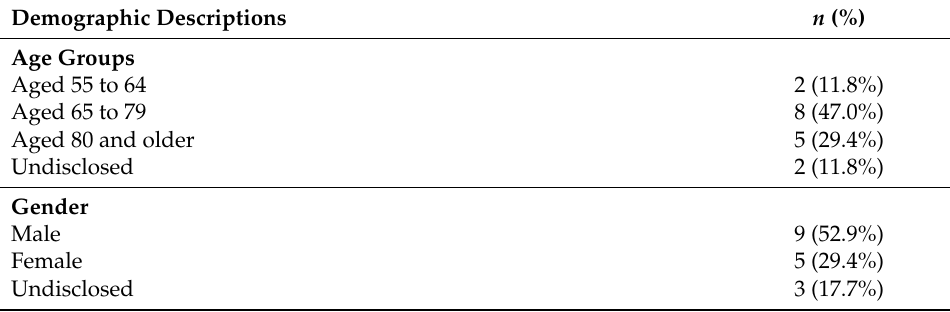
Table 2. Summary of participant demographic